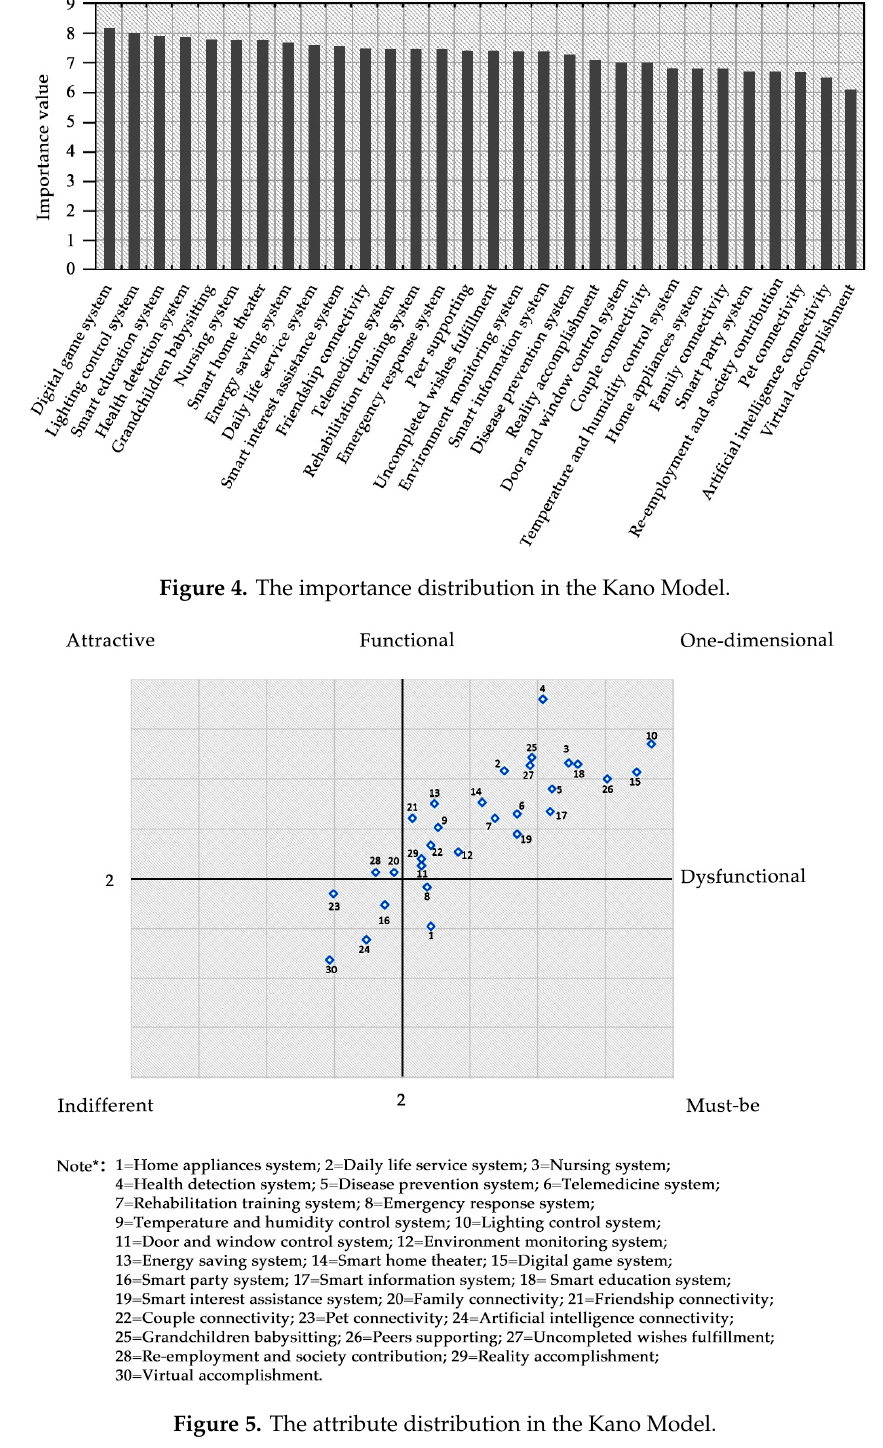
Figure 5 . The attribute distribution in the Kano Model